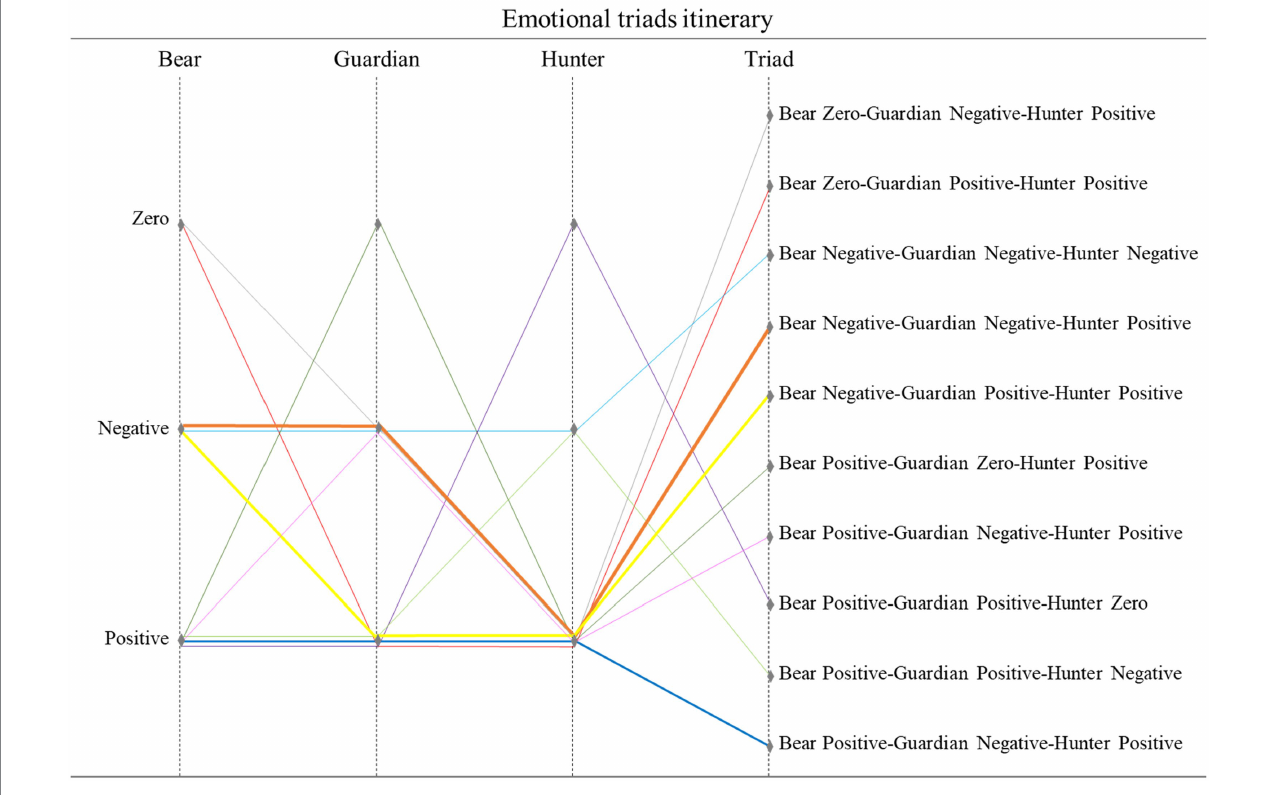
FIGURE 8 Orientation of emotional triads in the Bear